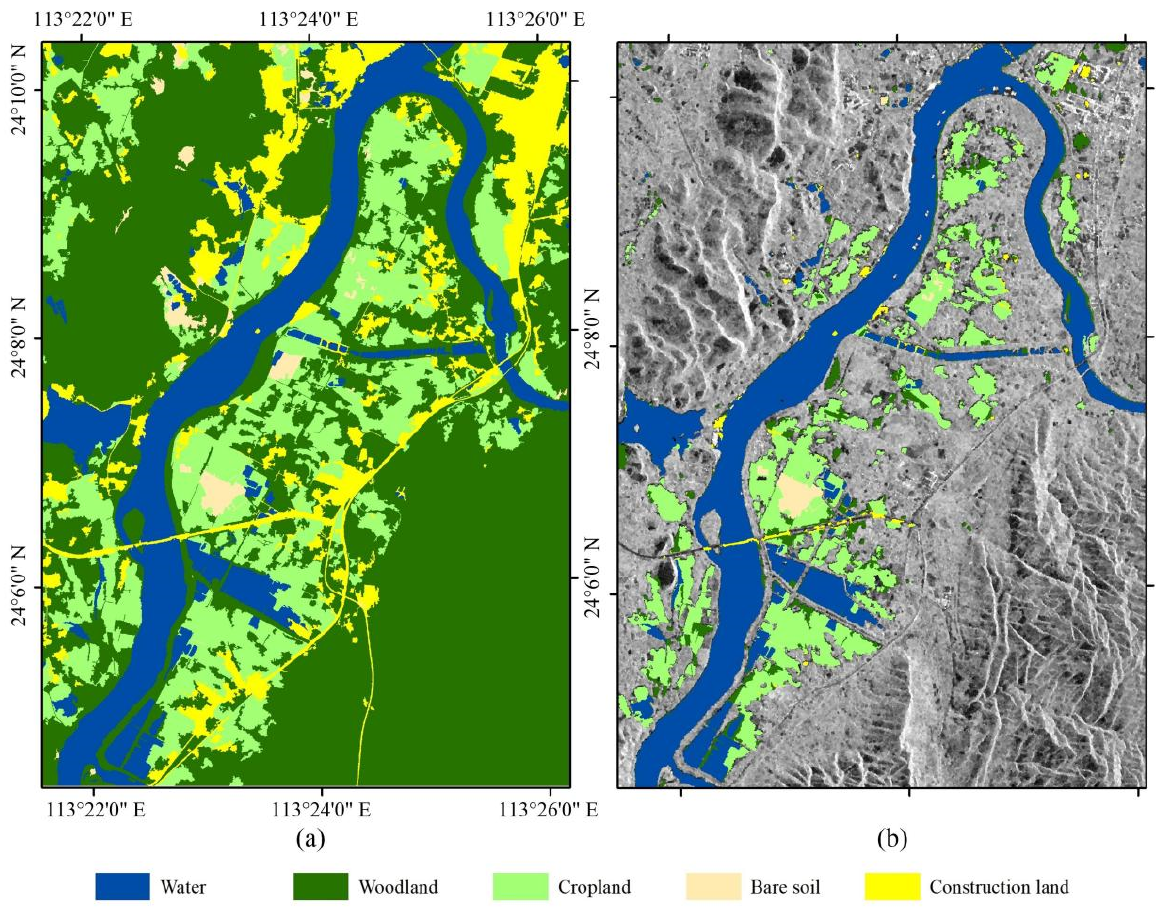
Figure 10. ( a ) The OSA-CNN classification result in Boluokeng. ( b ) The flood inundation map in Boluokeng.